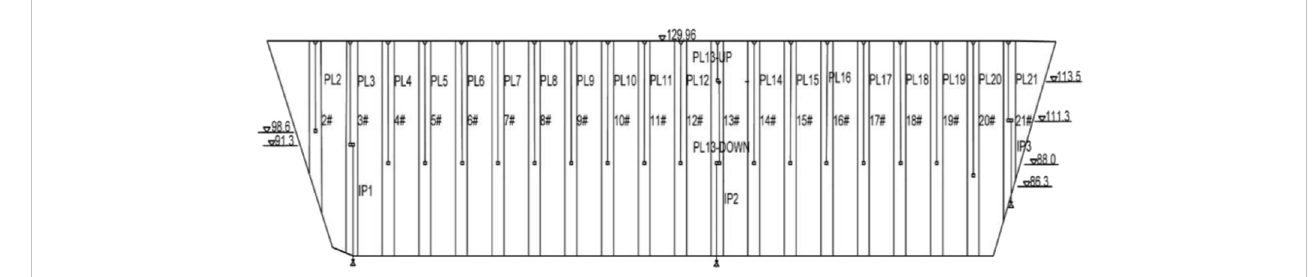
FIGURE 7 Pendulum systems for monitoring horizontal displacement.